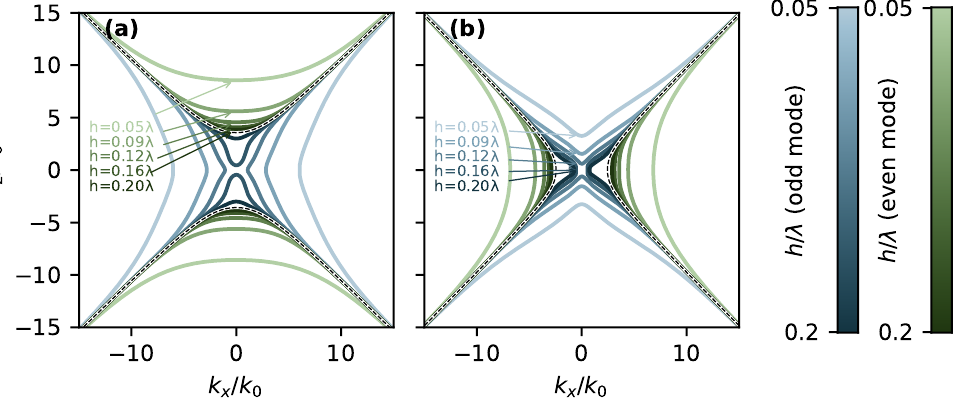
Figure 2. Even (green) and odd modes (blue lines) in symmetric three layer system (uniaxial metal-isotropic dielectric-uniaxial metal), for various spacer (isotropic dielectric layer) thicknesses. Both ( a ) type-1 ε o = − 2.37, ε e = − 1 and ( b ) type-2 ε o = − 1, ε e = − 7 systems are shown. The black dotted line shows solution from corresponding two-layer system of uniaxial metal and isotropic dielectric interface. The black dashed line shows single-interface